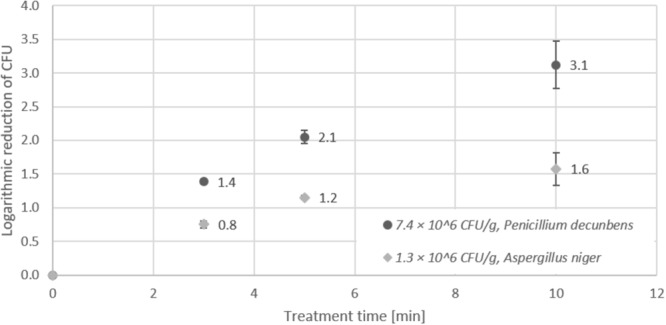
Effect of CAPP treatment of mold spores on lentil seeds. Inoculation was performed either with 7.4 × 106 CFU/g Penicillium decumbens spores or 1.3 × 106 CFU/g Aspergillus niger spores, prior to treatment of seeds for 3, 5, and 10 min in the DCSBD. Logarithmic reductions were represented as log10 CFU/g ± standard deviation. The limit of detection was 100 CFU/g.